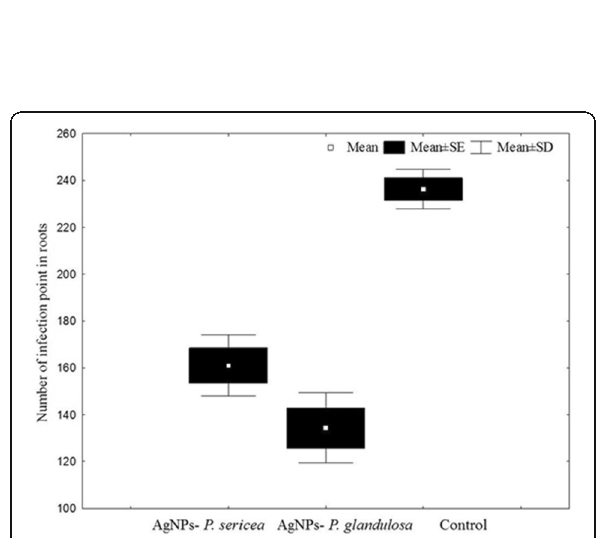
Fig. 3 Modification in the number of infection points in roots of cotton plants after 30 days of treatment with AgNPs from P. sericea and P. glandulosa (values are expressed as mean ± S.D., n = 10)